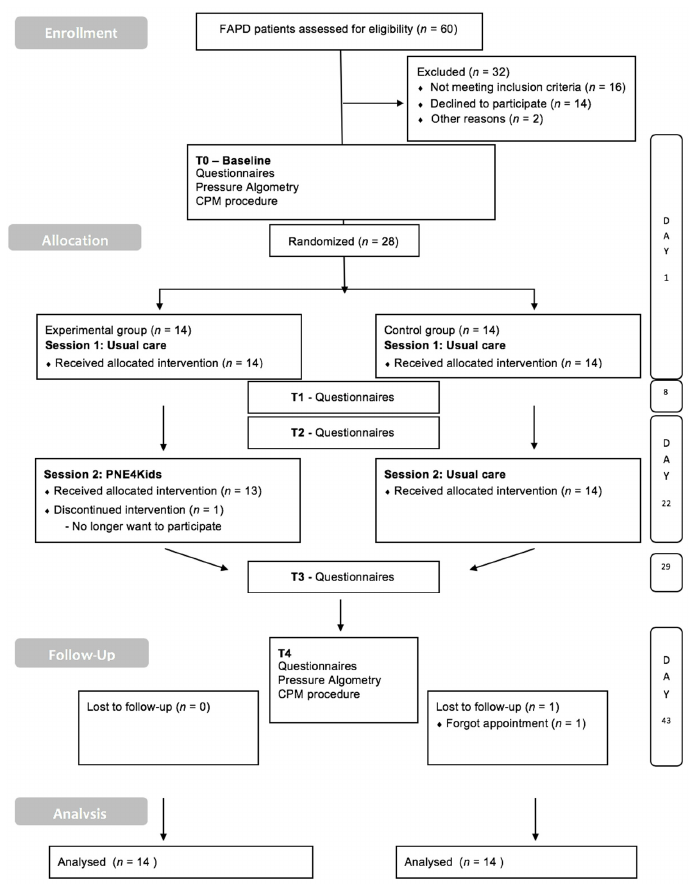
Figure 1. CONSORT Flow diagram.